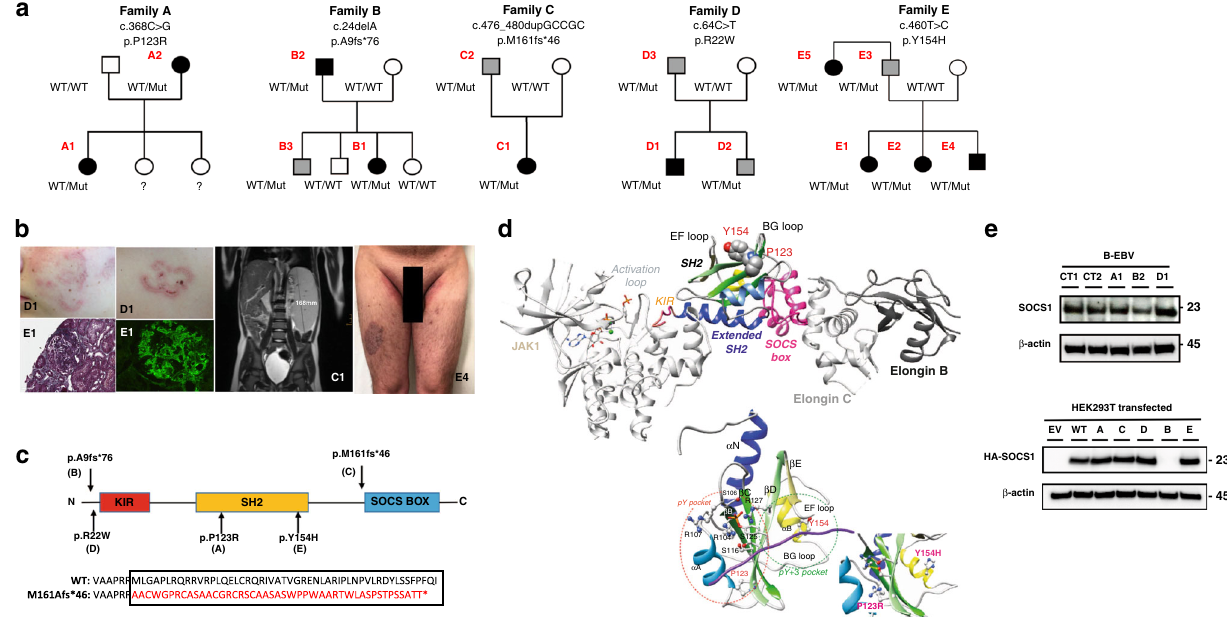
Fig. 1 Pedigrees and genetics of families with SOCS1 mutations. a Pedigrees of families with SOCS1 mutations. Squares: males; circles: females; black: affected mutation carriers; gray: unaffected mutation carriers. WT: wild-type SOCS1 allele. b Clinical manifestations in patients with SOCS1 mutations. Discoid lupus erythematosus (D1, upper left), active lupus nephritis (E1, lower left) with segmental cellular crescent associated with mesangial hypercellularity (Masson ’ s trichrome × 400) and glomerular capillary wall and mesangial C1q deposition by immuno fl uorescence microscopy, abdominal MRI showing splenomegaly (C1, middle), and plaque, intertrigous and guttata psoriasis (E4, right). c SOCS1 protein domains and locations of the mutations (upper panel, black arrows). The kinase inhibitory region (KIR) functions as a pseudosubstrate that can inhibit the tyrosine kinase activity of Janus kinase (JAK) proteins. The SRC-homology 2 (SH2) domain binds the activation loop of the JAK proteins ’ catalytic domain. The SOCS box recruits the ubiquitin- transferase system and initiates the proteasomal degradation of JAK proteins. The SOCS1 M161Afs*46 mutant leads to a predicted 46-residue neopeptide in the SOCS box domain three amino acids shorter than the wild-type protein (lower panel). d Top panel: position of the P123 and Y154 in human SOCS1 within a 3D model of the JAK1/SOCS1 complex. Bottom panel: a model of the human SOCS1 ’ s SH2 domain. The two mutated amino acids (P123R and Y154H) are highlighted in the phosphotyrosine peptide binding groove (the pY and pY + 3 pockets). The possible location of a phosphotyrosine peptide is shown in purple. e SOCS1 protein expression in patient-derived cells and transfected cells. Top : Western blot (WB) analysis of lysates from Epstein-Barr- virus (EBV)-tranformed B cells from patients A1, B2, and D1 and from two healthy controls (CT1 and CT2), following incubation with anti-SOCS1 antibodies (upper panel) or anti-actin antibodies as a loading control (lower panel). Bottom: HEK293T cells transiently transfected with an empty vector (EV), a vector coding for hemagglutinin (HA)-tagged wild-type (WT) SOCS1 protein, or vectors coding for the fi ve HA-tagged mutant SOCS1 proteins. Lysates were incubated with anti-HA antibodies (upper panel) or anti-actin antibodies as a loading control (lower panel). Data are representative of two independent